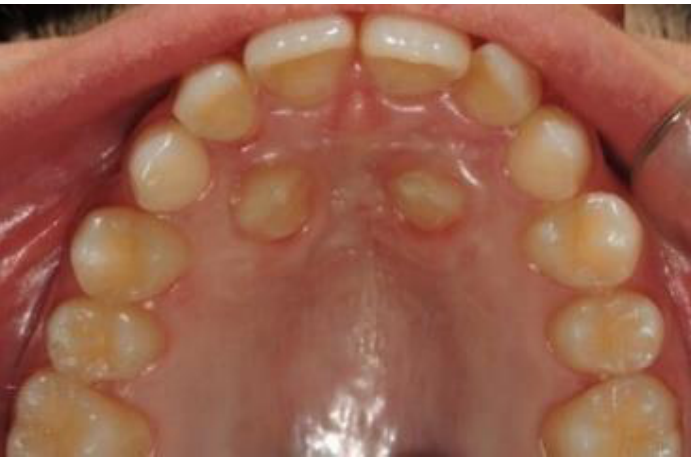
Figure 6. Intra-oral photo 2 months after surgery.